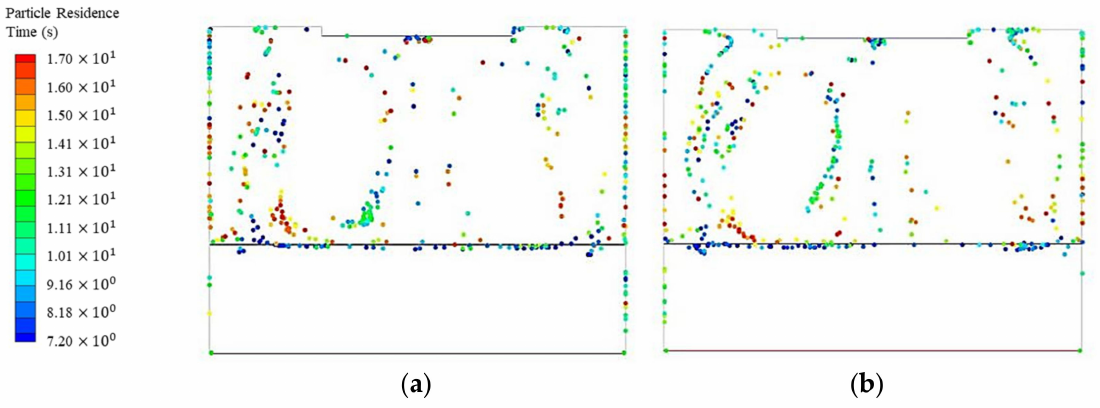
Figure 16. 10 µ m inclusions distribution with different types ( a ) MnO and ( b ) Al 2 O 3